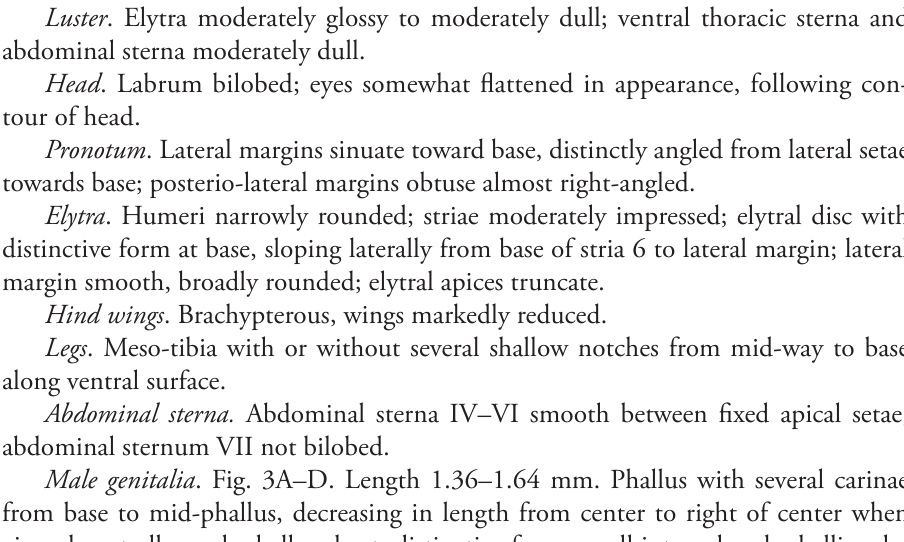
abdominal sterna moderately